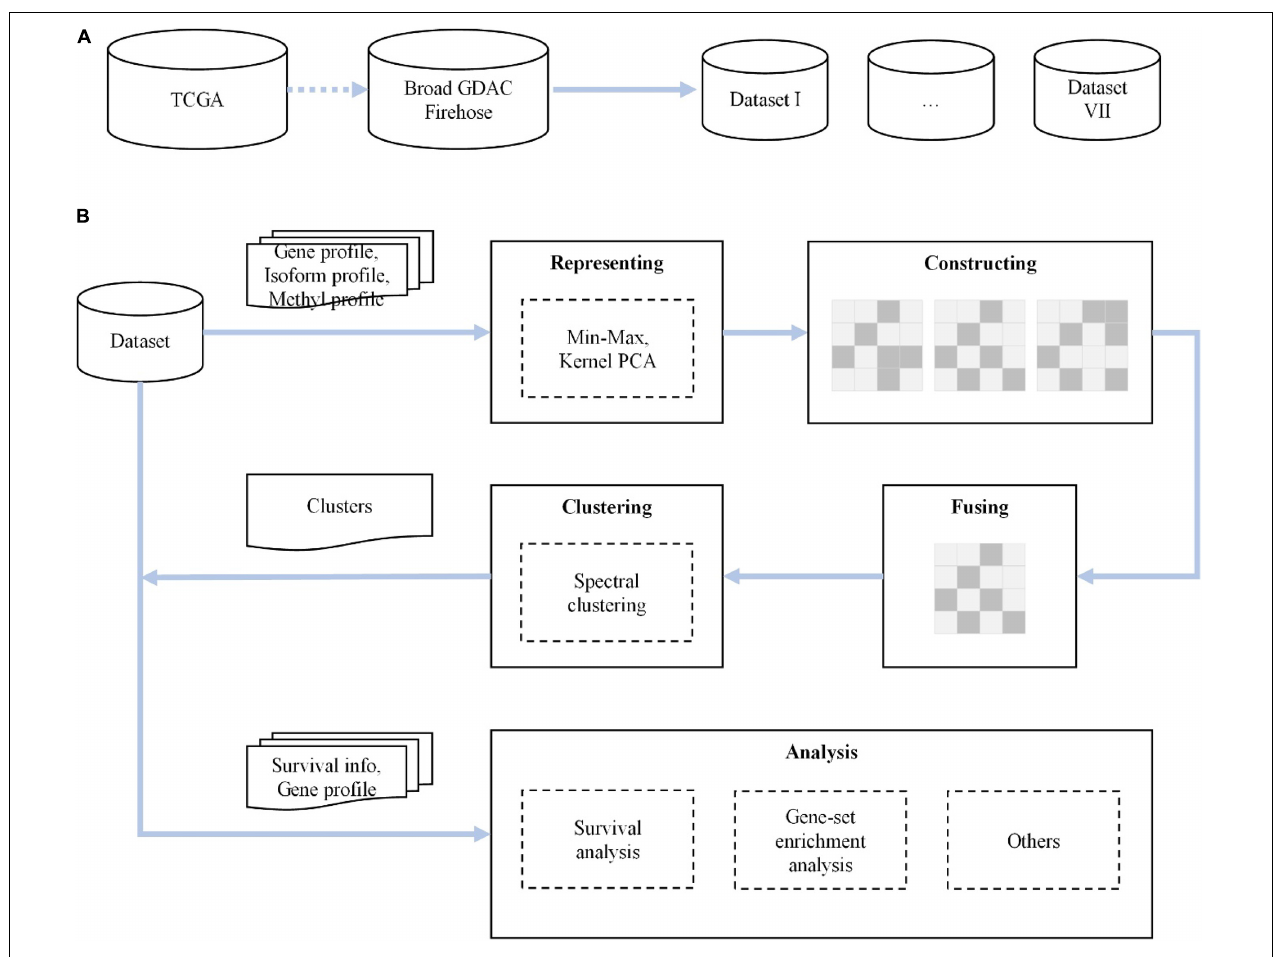
FIGURE 1 | The flowchart of our novel method. (A) We first collect and check seven cancer datasets from The Cancer Genome Atlas (TCGA) dataset of the Broad Institute GDAC Firehose. (B) For each dataset, after representing, constructing, fusing, and clustering for gene, isoform, and DNA methylation data, we carry out survival analysis, gene set enrichment analysis, and others.